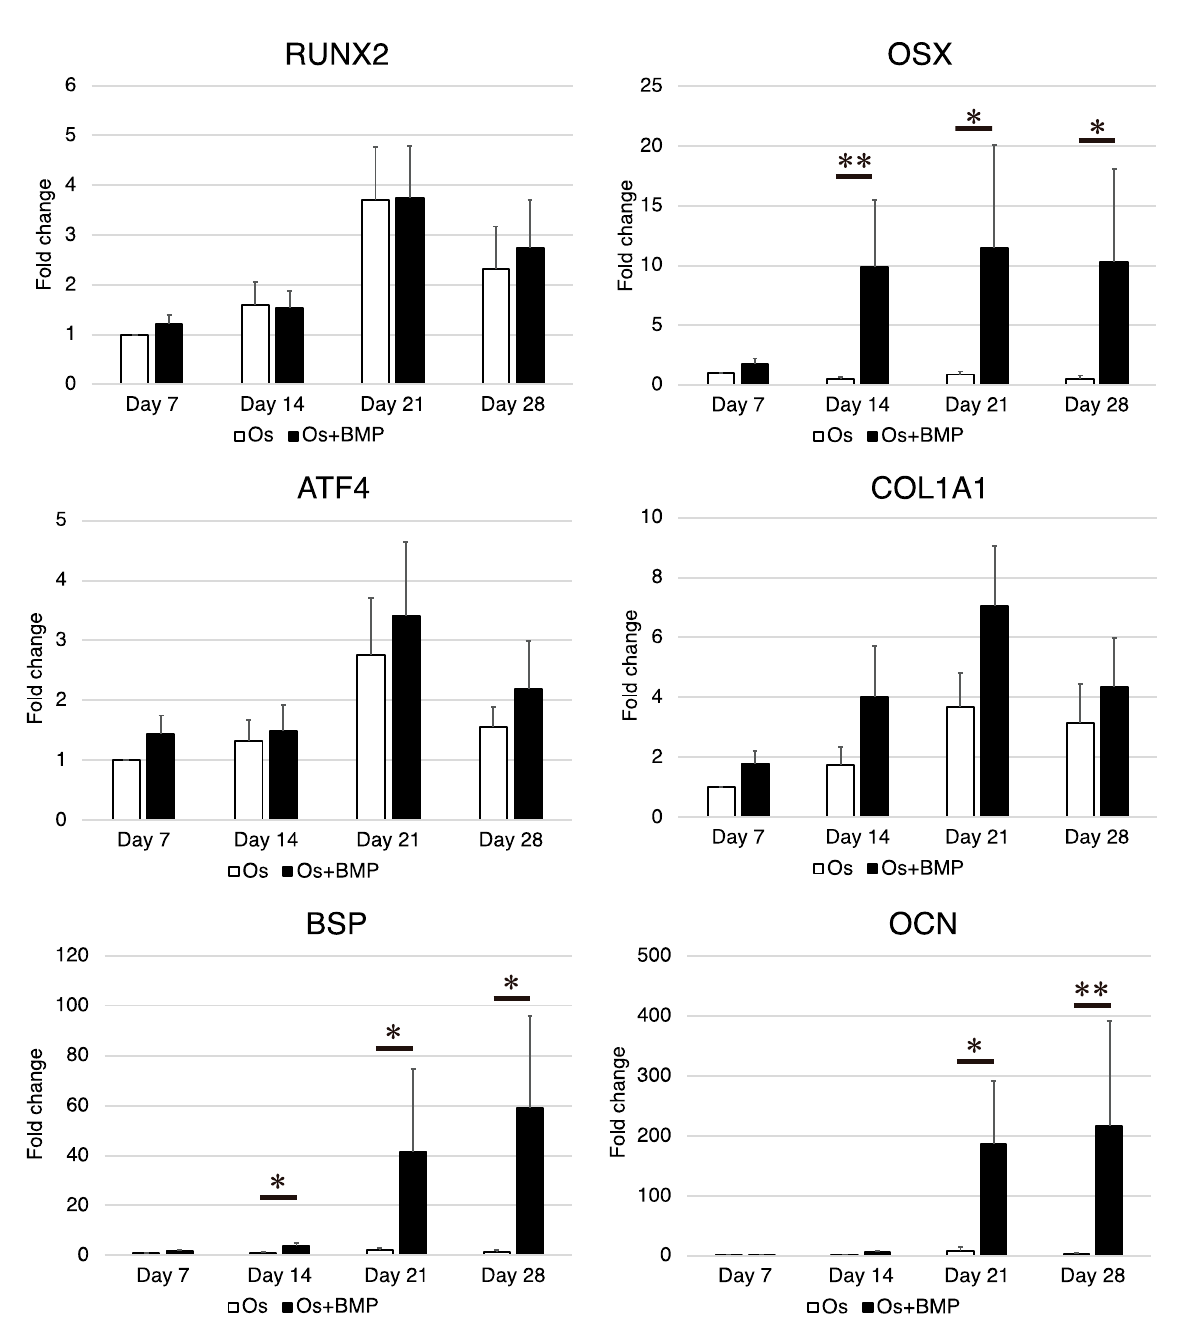
Figure 5. Analysis of the expression of osteoblast-related genes in non-hypertrophic nonunion cells (NHNCs). Real-time reverse transcription-polymerase chain reaction (RT-PCR) for runt-related transcription factor 2 ( RUNX2 ), osterix ( OSX ), activating transcription factor 4 ( ATF4 ), collagen type I ( COL1A1 ), bone sialoprotein ( BSP ), and osteocalcin ( OCN ) in the total RNA extracted from NHNCs in osteogenic medium (Os) and Os with E-BMP-2 (Os + BMP) on days 7, 14, 21, and 28. NHNCs incubated in Os for 7 days were used as the control. * p < 0.05 and ** p < 0.01 in the indicated